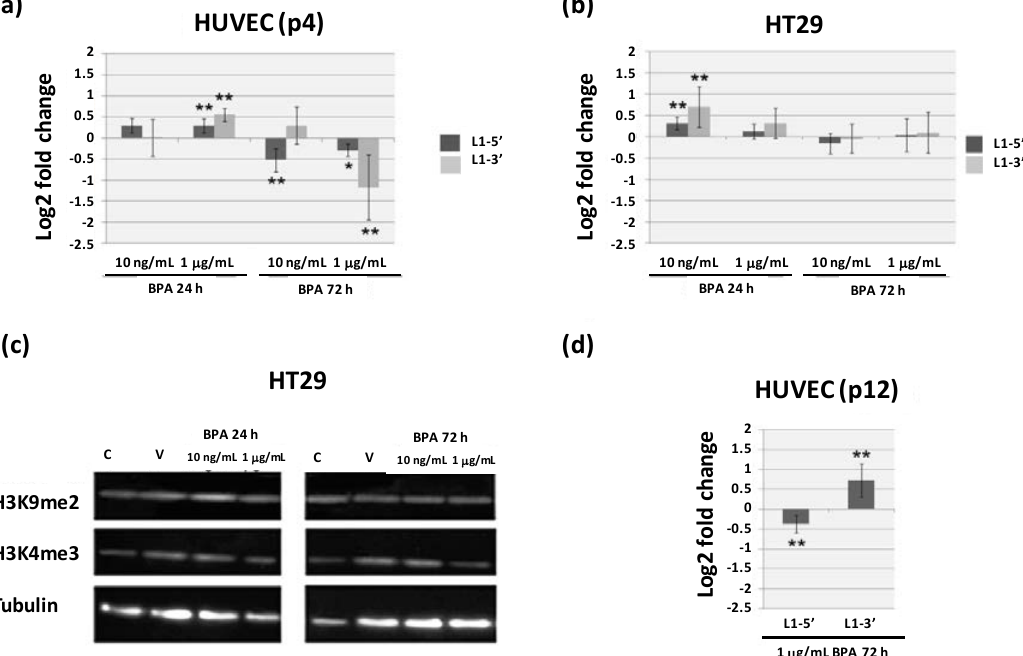
Figure 1. Analysis of Bisphenol A (BPA) effects on Long Interspersed Element-1 (L1) transcription levels and H3K9me2 and H3K4me3 epigenetic marks. ( a , b ) L1-5' and L1-3' transcriptional analysis on young (passage 4, p4) Human Umbilical Vein Endothelial Cells (HUVEC) ( a ) and human colon adenocarcinona cell line HT29 ( b ) after 24 and 72 h exposure to 10 ng/mL or 1 µg/mL BPA; ( c ) Western blotting detection of H3 dimethylation at lysine 9 (H3K9me2) and H3 trimethylation at lysine 4 (H3K4me3) on HT29 cells after 24 and 72 h exposure to 10 ng/mL or 1 µg/mL BPA showing a single 17 kDa band identical to that observed for cells grown in control medium or in medium supplemented with vehicle, α-tubulin was used as loading control; ( d ) L1-5' and L1-3' transcription levels on aging HUVEC at passage 12 (p12) after 72 h exposure to 1 µg/mL BPA. Results in ( a ), ( b ), and ( d ) are shown as the mean log2 fold change (2 −ΔΔ C t ) ± standard deviation in relation to equivalent cells exposed to vehicle alone. Values significantly different from vehicle are indicated, Student’s t test ** p < 0.01 and * p <